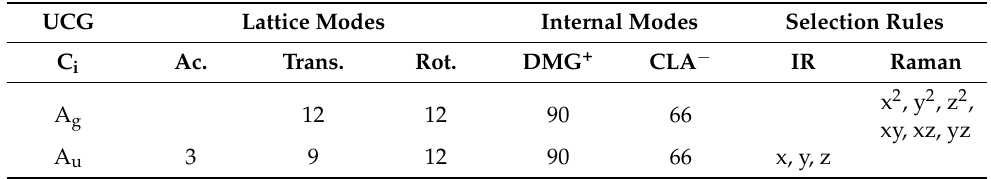
Table 5. Classification of the fundamental modes ( k = 0) for the N,N-dimethylglycine –chloranilic acid (DMG + –CLA − ) co-crystal.